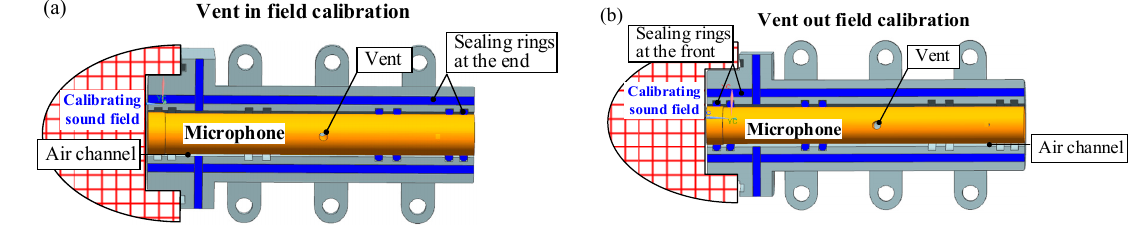
Figure 17. ( a ) Planned vent in field calibration. ( b ) Planned vent out field calibration.